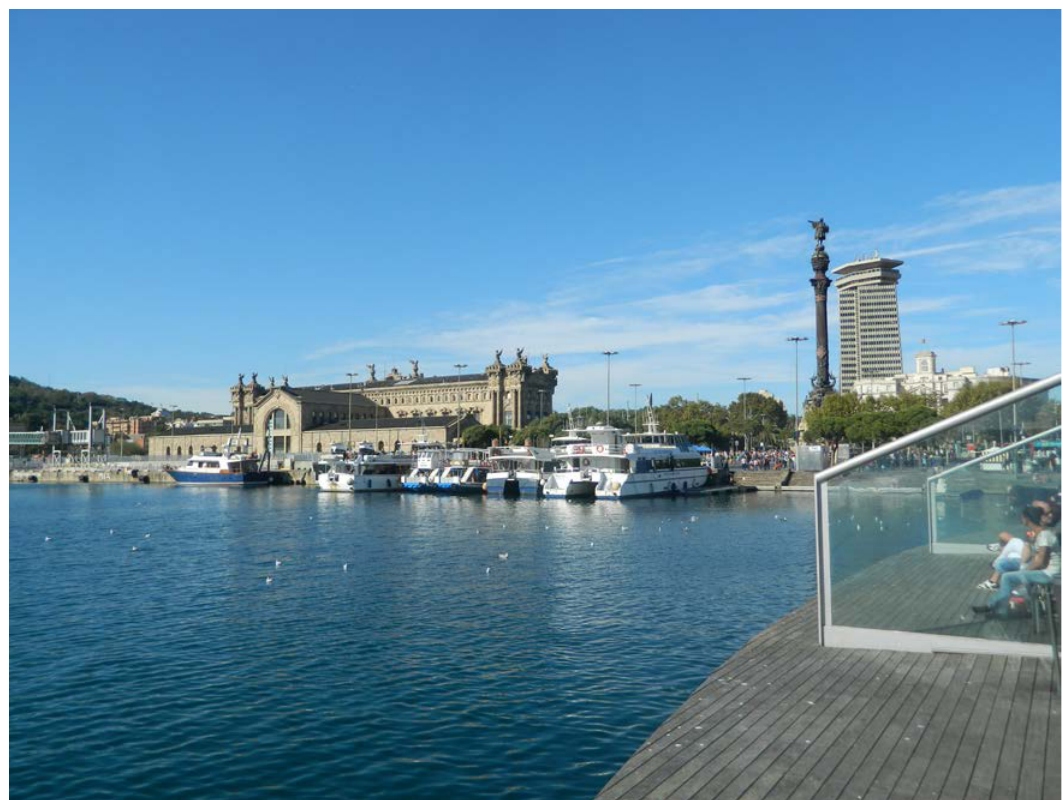
Figure 13: The seascape of Barcelona,